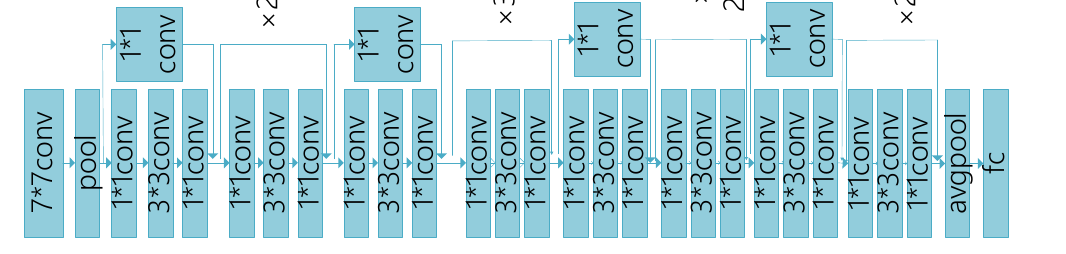
Figure 8. ResNet-101 Network